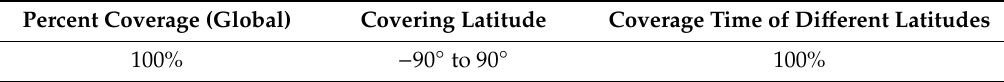
Table 2. Cumulative coverage and latitudes coverage.